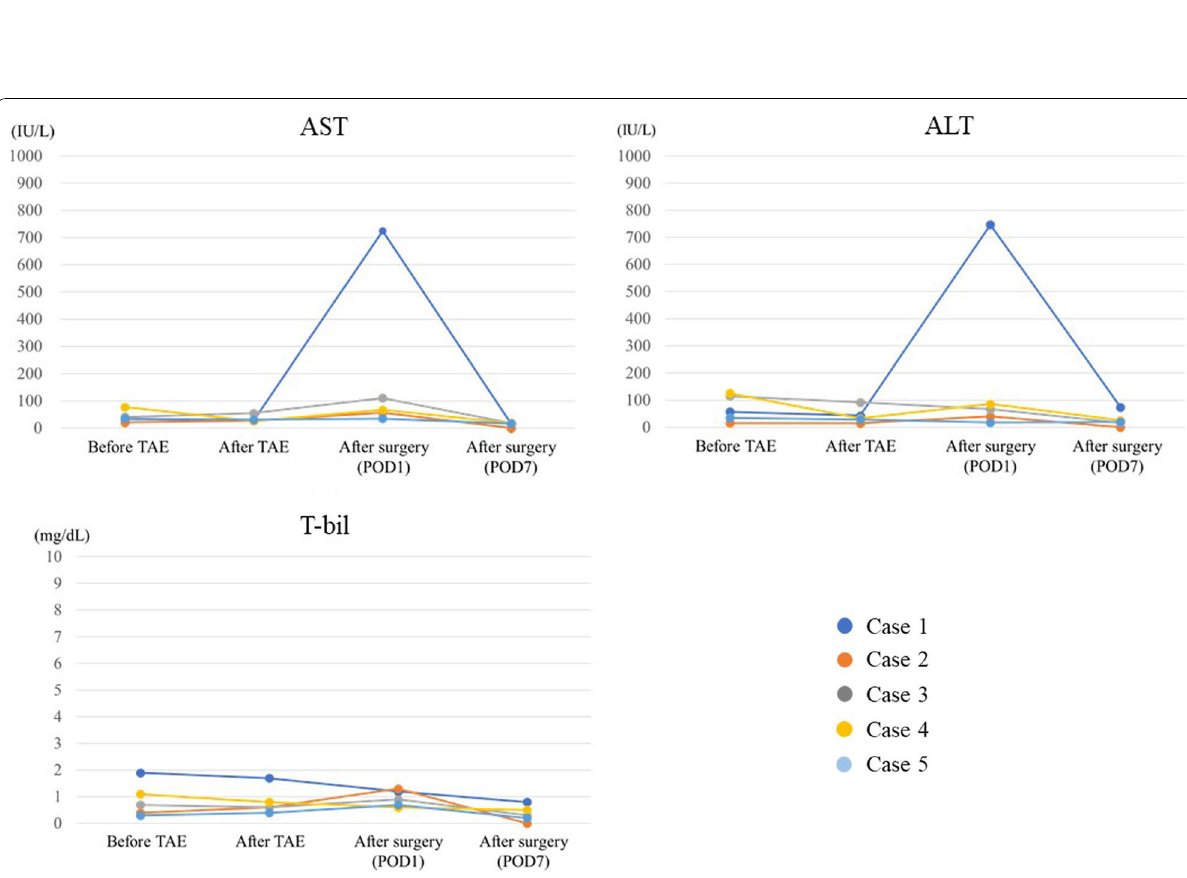
Fig. 3 Laboratory data related to the liver function changing before or after the TAE or surgery. The elevation of AST or ALT was not shown in the clinical course other than their elevation at the postoperative day 1 of case 1. There was no elevation of T-bil in all cases during the processes. TAE trans-arterial catheter embolization; AST aspartate aminotransferase; ALT alanine aminotransferase; T-bil total bilirubin; POD postoperative